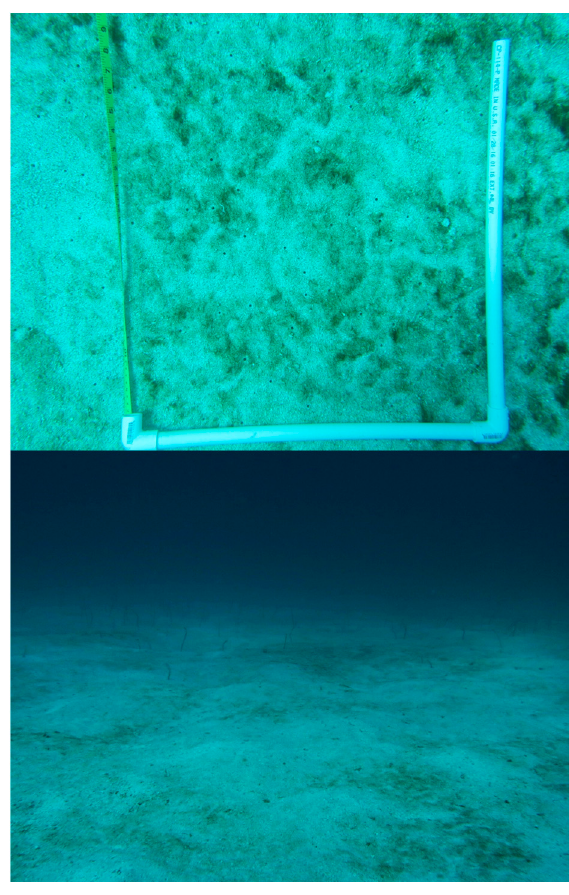
Figure A14 . Underwater picture of SLC relevance of cyanobacteria mats over sandy bottoms (Favoretto et al., unpublished data).